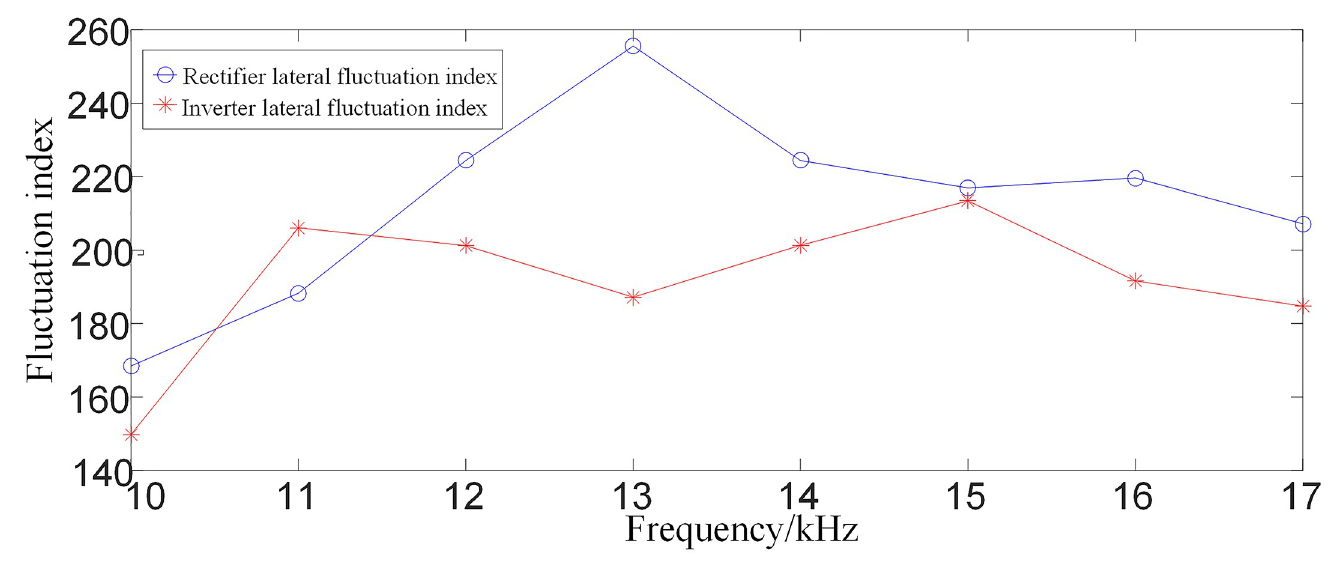
Fig 5. Multi-scale S transform fluctuation index for internal